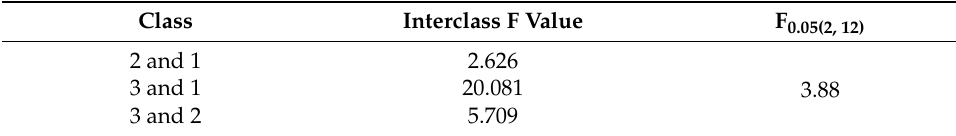
Table 6. F-test for discrimination effect of water sample in the mining area.